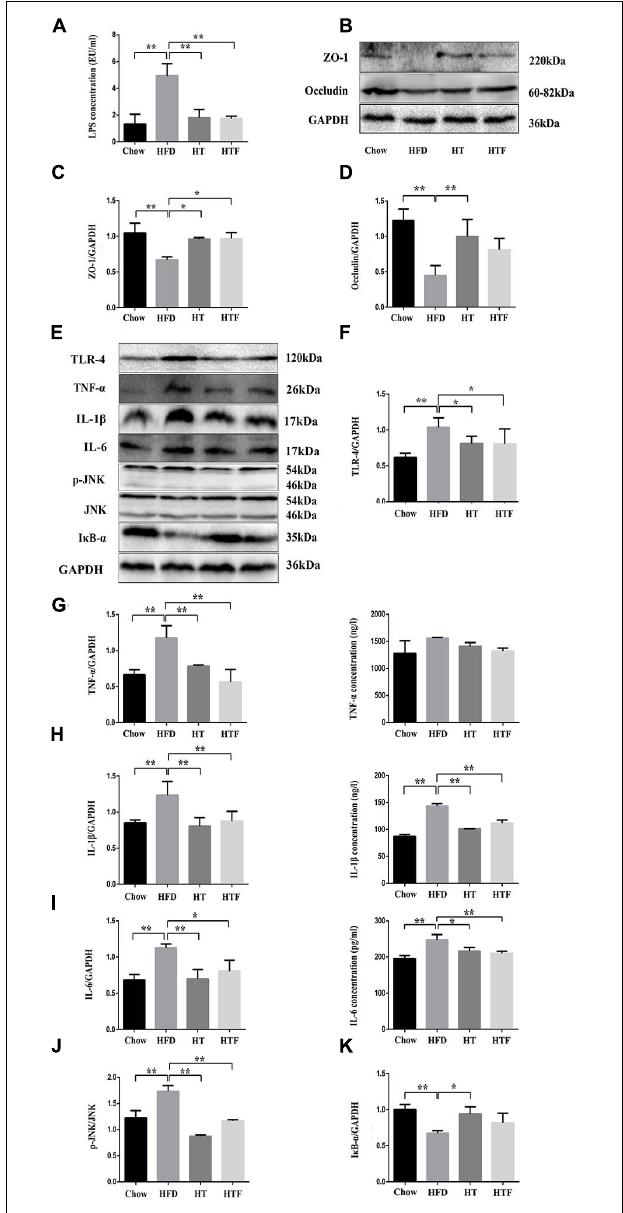
FIGURE 2 | HT and HTF protected intestinal integrity, decreased concentration of plasma LPS and alleviated inflammation in HFD mice. Effects of HT and HTF treatment on plasma endotoxin using a Chromogenic End-point Tachypleus Amebocyte Lysate (A) The expression of Occludin, ZO-1 and GAPDH in ileum was assessed using western blot (B) . Bar graphs represent normalized data of Occludin /GAPDH (C) and ZO-1 /GAPDH (D) n = 3. The expression of Occludin, TLR-4, TNF- α , IL-1 β , IL-6, p-JNK, I κ B- α and GAPDH in liver was assessed using western blot (E) . Bar graphs represent normalized data of TLR-4/GAPDH (F) , TNF- α / GAPDH and the concentration of TNF- α in liver (G) , IL-1 β /GAPDH and the concentration of IL-1 β in live (H) , IL-6/GAPDH and the concentration of IL-6 in live (I) , p-JNK/JNK (J) , I κ B- α /GAPDH (K) n = 3. Molecular weight markers were indicated as kilodaltons (kDa), Graph bars with statistically significant results ( P ≤ 0.05) based on one-way ANOVA analysis followed by Tukey’s honest significant difference post hoc tests. Data are shown as mean ± s.e.m ( ∗ P ≤ 0.05, ∗∗ P ≤